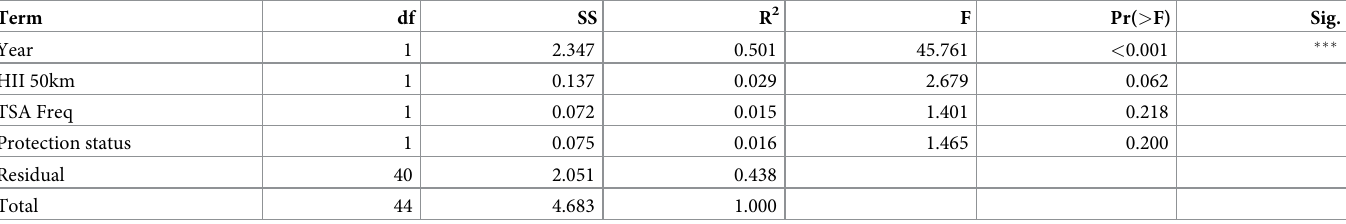
Table 4. Results of the Permutational Multivariate Analysis of Variance (PERMANOVA) using the bray-curtis dissimilarity index to determine the effects of covar- iates in changing the composition of benthic communities, based on